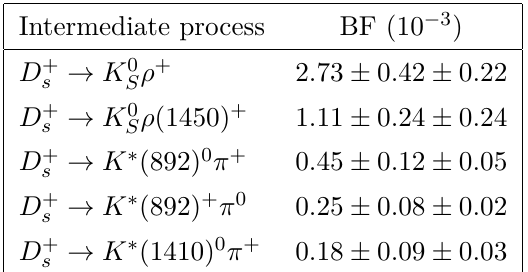
Table 9 . The BFs for various intermediate processes with the final state K 0 second uncertainties are statistical and systematic,